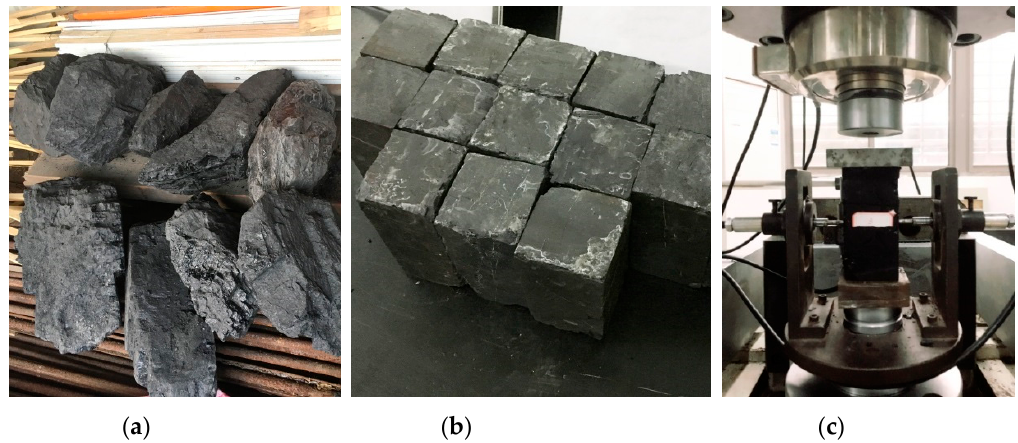
Figure 5. Coal specimens laboratory test procedures: ( a ) Coal blocks; ( b ) standard coal specimens; ( c ) Loading tests on RMT-150C.